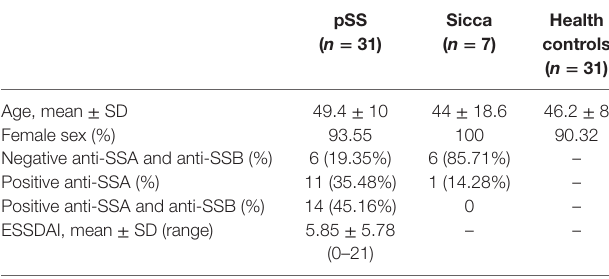
Table 1 | Characteristics of primary Sjögren’s syndrome (pSS) patients, Sicca, and health